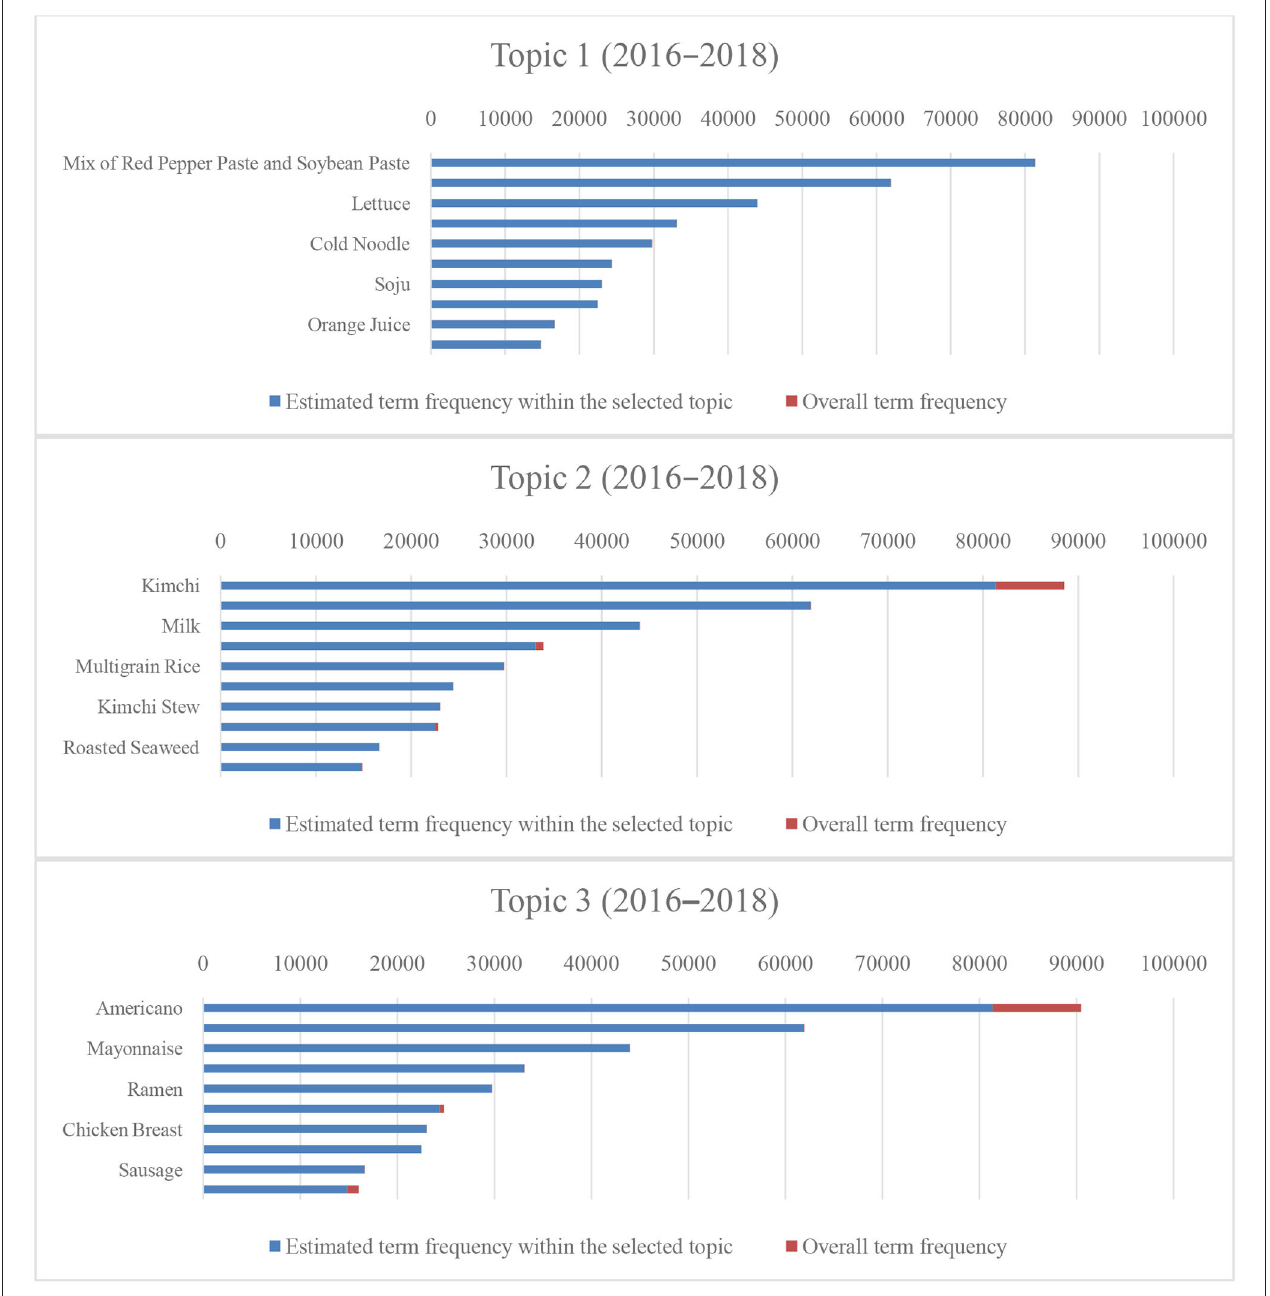
FIGURE 7 | Number of tokens and proportions of entire tokens for the top 10 menus (2016–2018).